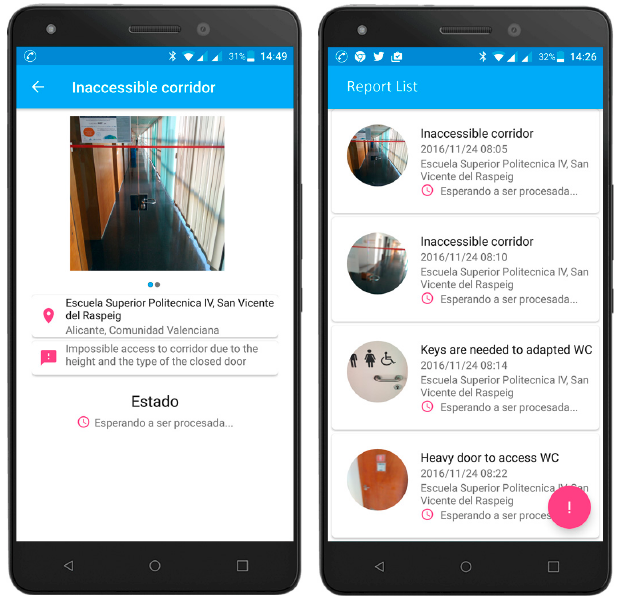
Figure 10. App for Accessibility Self-Reporting Issues.